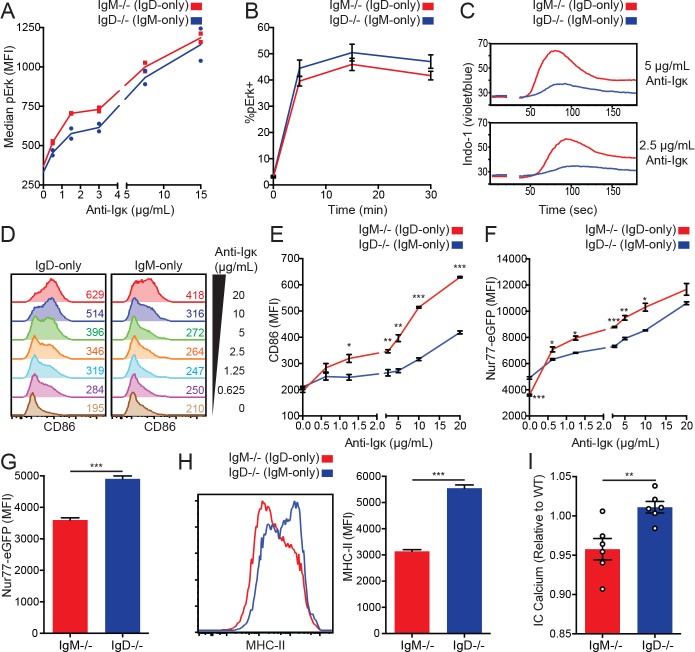
IgD signals strongly in vitro but weakly in vivo.(A) Median intracellular pErk in splenic CD23+ B cells stimulated with anti-Igκ for 15 min. (B) Erk phosphorylation kinetics in splenic CD23+ B cells stimulated with 15 μg/mL anti-Igκ. (C) Splenocytes from IgM−/− and IgD−/− mice were loaded with Indo-1 and stimulated with 2.5 or 5 μg/mL anti-Igκ. B220+CD23+CD93- Fo B cells are compared. (D) CD86 induction in CD23+ IgM−/− and IgD−/− splenocytes stimulated with anti-Igκ for 18 hr. (E) Summary data for CD86 MFI in (D). (F) Nur77-eGFP induction in cells from (D). (G) Nur77-eGFP in cells from (D) incubated with medium alone (0 μg/mL anti-Igκ). (H) Representative histograms and summary data for MHC-II induction in unstimulated cells from (D). (I) Basal calcium in unstimulated IgM−/− and IgD−/− Fo B cells was calculated by normalizing the geometric mean of [Indo-1(violet)/Indo-1(blue)] to WT B cells in the same experiment. For (A), signaling in cells from n = 2 IgM−/− and IgD−/− mice is displayed, and results for 1.5, 3, and 15 μg/mL of anti-Igκ were replicated in n = 3 independent experiments. Data in (B) was compiled from n = 3 independent experiments with n = 3 mice of each genotype in each experiment. Data in (C) are representative of n = 4 independent experiments for 5 μg/mL and n = 2 independent experiments for 2.5 μg/mL. For (D-H), values were calculated for splenocytes from n = 3 mice of each genotype. For (I), basal calcium ratios from n = 6 independent experiments are compiled. Welch’s t test was used to calculate p values, and mean ±SEM is displayed. *p<0.05, **p<0.01, ***p<0.001.10.7554/eLife.35074.013Figure 2—source data 1.Numerical data corresponding to Figure 2A and B, E-I, and Figure 2—figure supplement 1A.Numerical data corresponding to ERK phosphorylation in Figure 2A–B. Numerical data corresponding to activation marker upregulation in Figure 2E–H. Numerical data corresponding to basal calcium in Figure 2I. Numerical data corresponding to S6 phosphorylation in Figure 2—figure supplement 1A.10.7554/eLife.35074.014Figure 2—source data 2.Numerical data corresponding to basal calcium in Figure 2I.